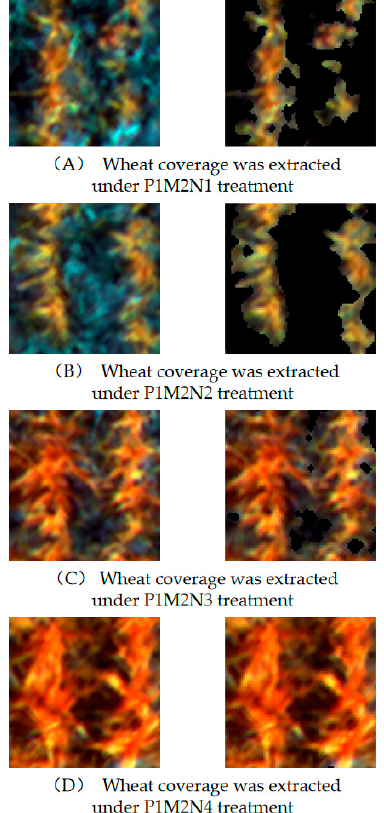
Figure 4. Wheat coverage of variety 1 (P1) in treatments with the same wheat densities (M2) and different nitrogen fertilizer rate wheat densities: ( A ) N1, ( B ) N2, ( C ) N3, ( D ) N4.